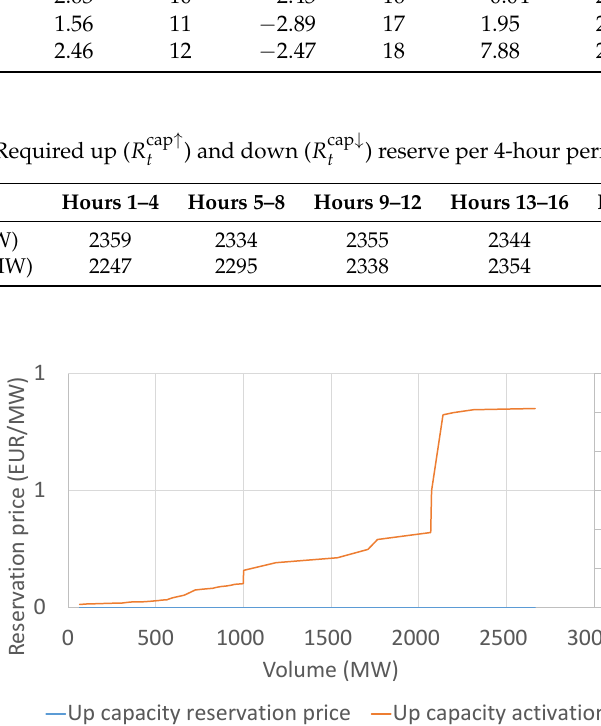
Figure 2. Up capacity reservation ( λ cap